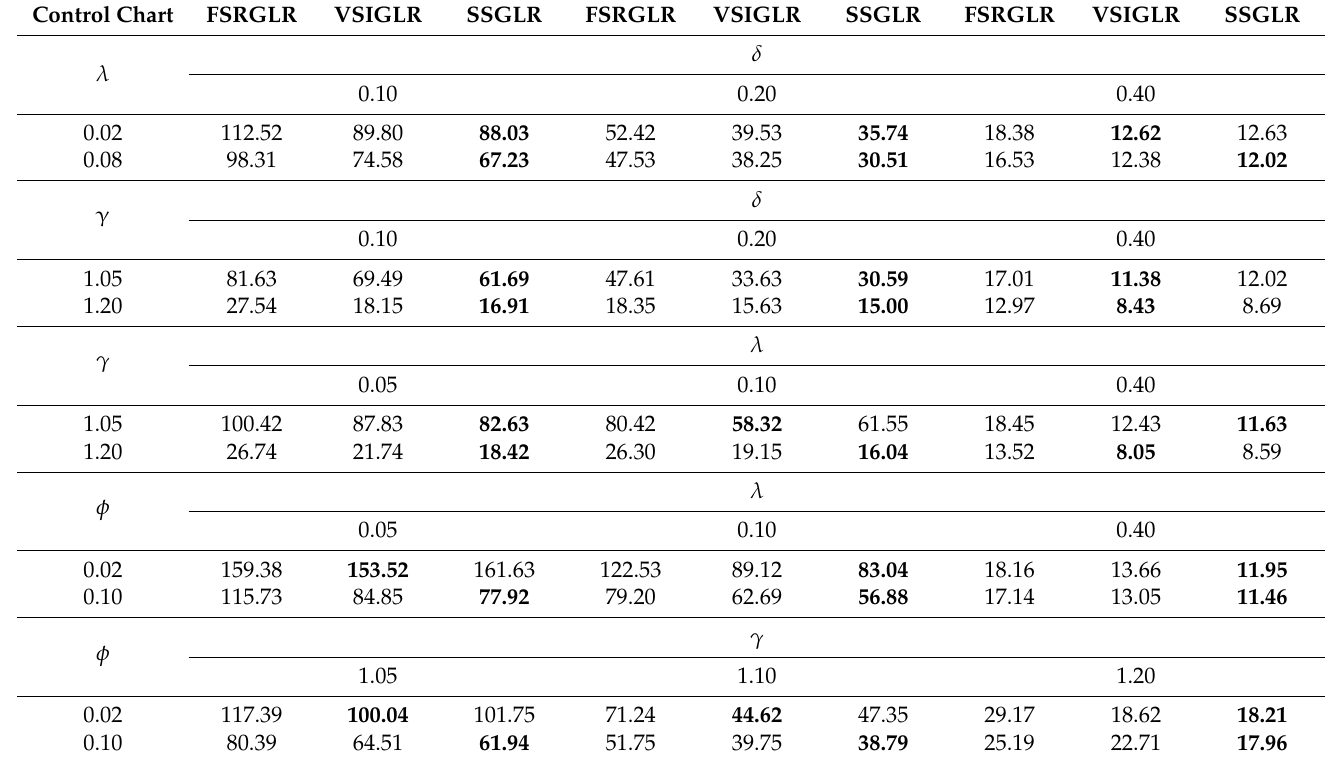
Table 3. The ATS 1 values for the FSRGLR, VSIGLR, and SSGLR control charts under the simultaneous shifts ( m = 400 and ATS 0 =